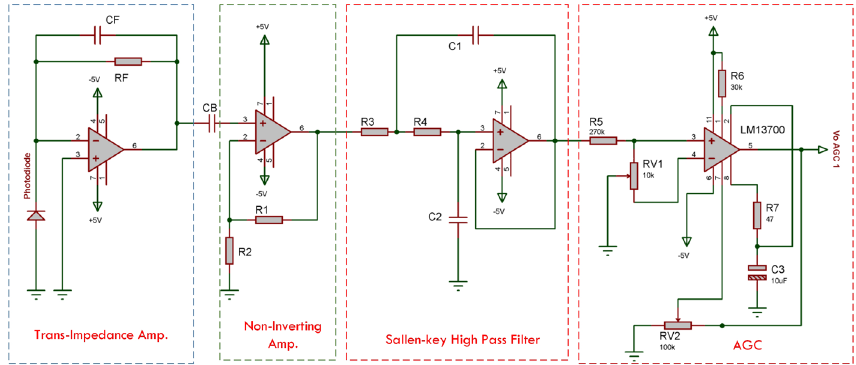
Fig. 4. Proposed analog front-end receiver circuit which will be applied in VLC